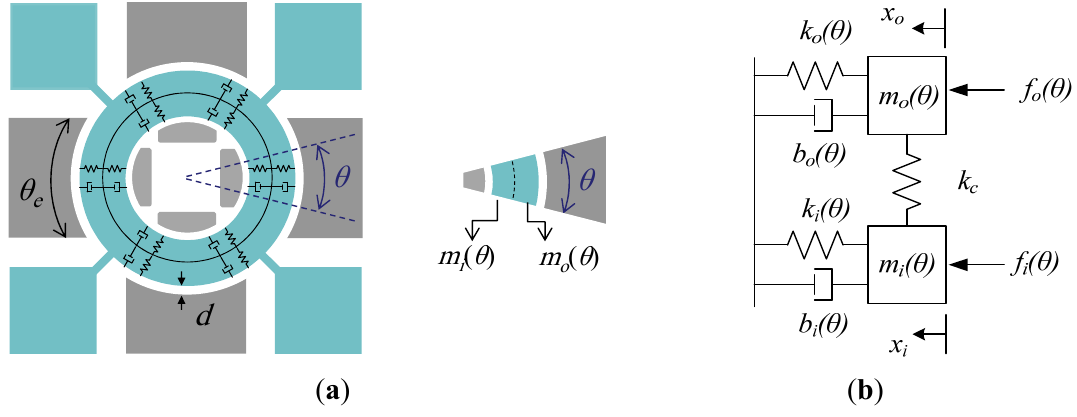
3. ( a ) The schematic view of the ring resonator; ( b ) The equivalent mass-spring-damper system of an infinitesimal element of the ring